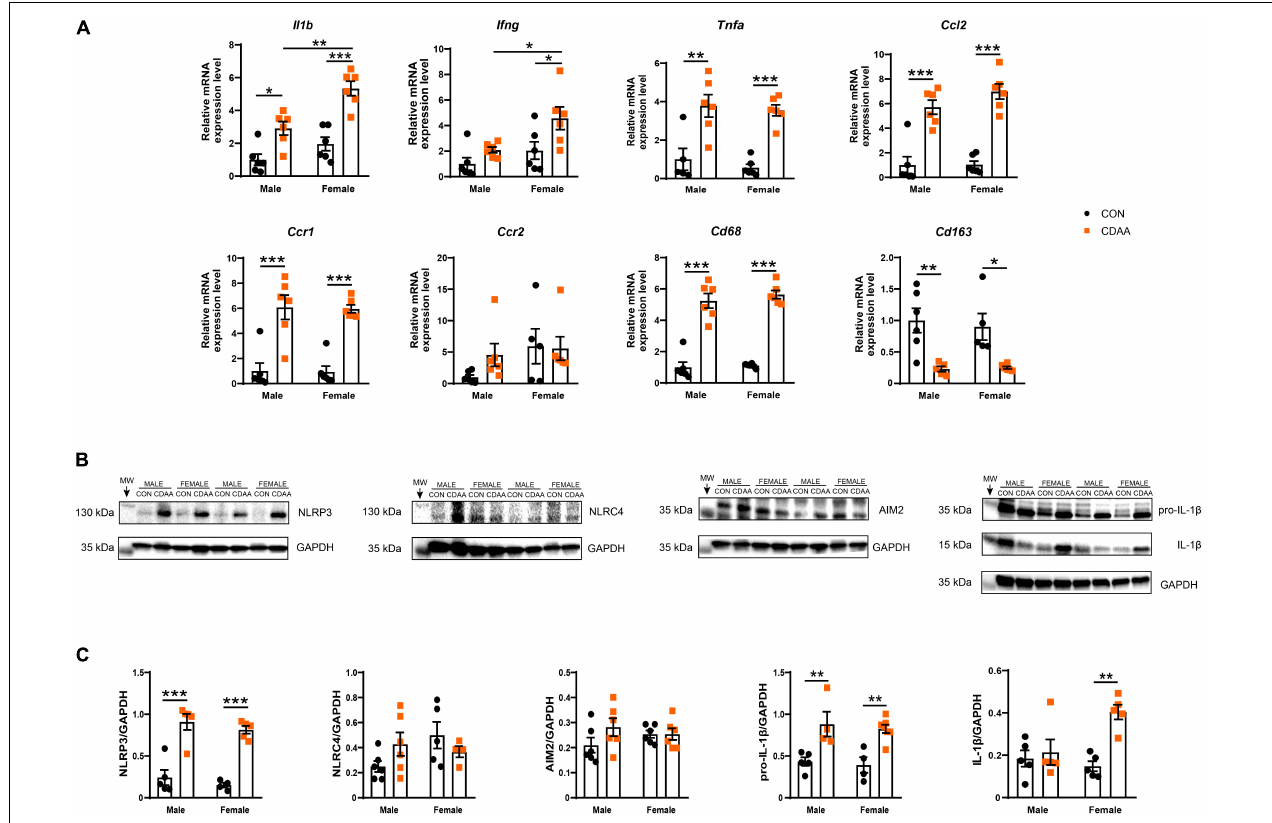
FIGURE 6 | Hepatic inflammation in CDAA-induced NASH. Gene expression of pro-inflammatory ( Il1b, Ifng, Tnfa ), chemokine ( Ccl2, Ccr1, Ccr2 ), and macrophage markers ( Cd68, Cd163 ) genes were performed by qRT-PCR and was normalized to Rpl13a , as a housekeeping gene (A) . Representative Western blot analysis of inflammasomes sensors NLRP3, NLRC4, and AIM2, as well as pro-IL-1 β and cleaved IL-1 β (B) . Quantification of the Western blots (C) . Results are shown as mean ± standard error of mean (SEM). * P < 0.05 was considered significant, ** P < 0.01 was considered significant, *** P < 0.001 was considered